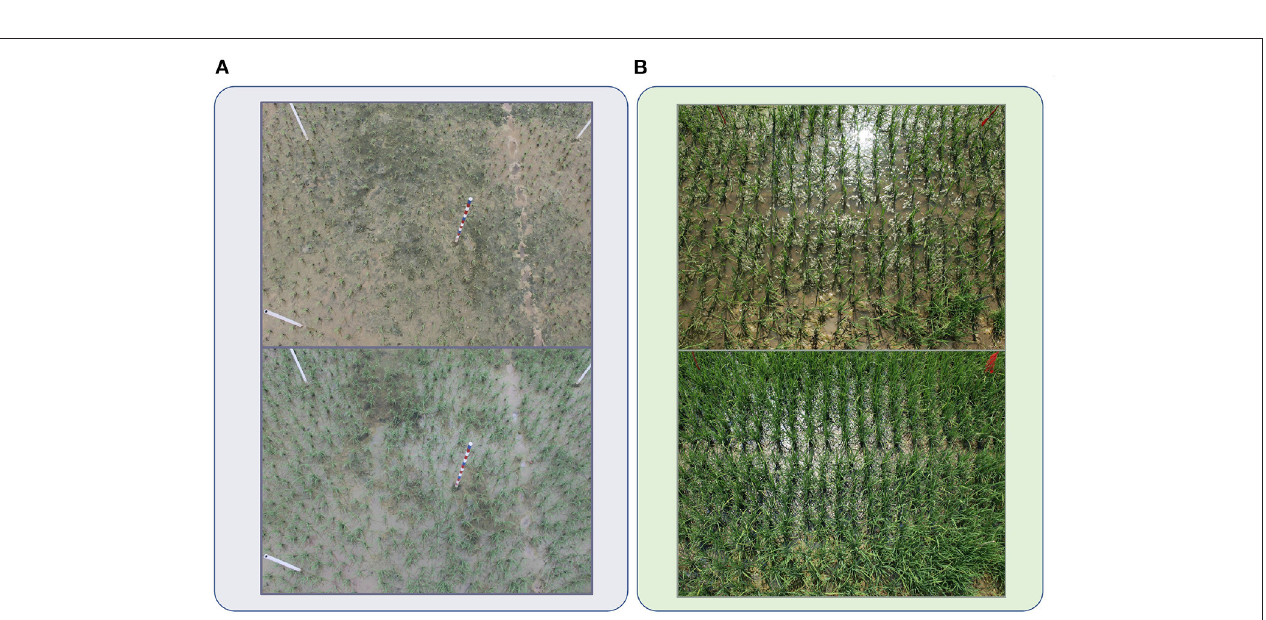
FIGURE 3 | Samples from RPC datasets. (A) Images captured in Guangxi. (B) Images captured in Jiangxi.